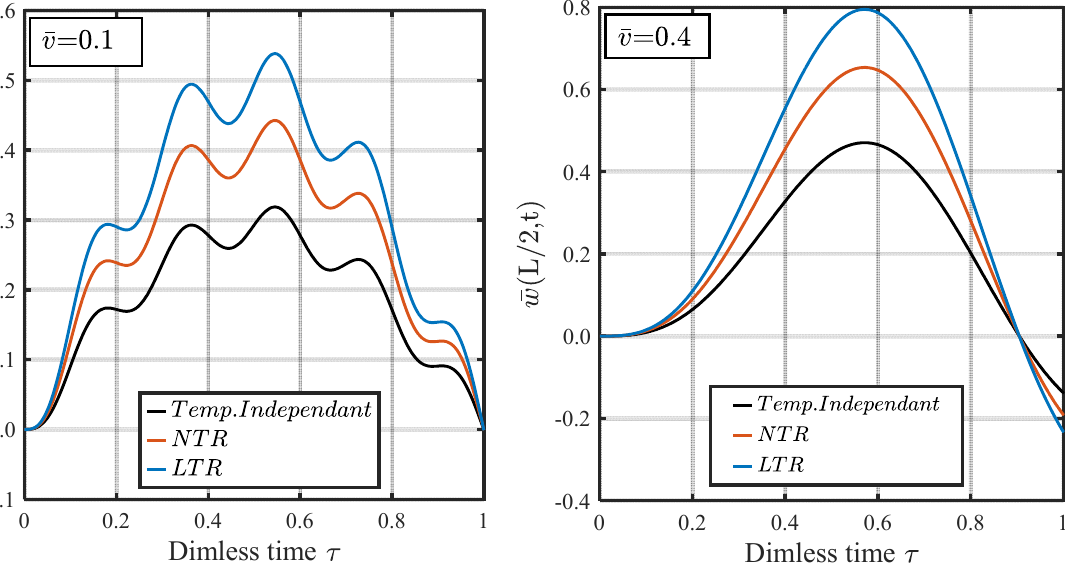
Figure 7. Influence of the axial gradient index on the variation in the maximum normalized central dynamic deflection with the velocity ( k z = 0.2 ) ; (__) temperature-independent, (- -) temperature- dependent ( ∆ T = 80, LTR ) .